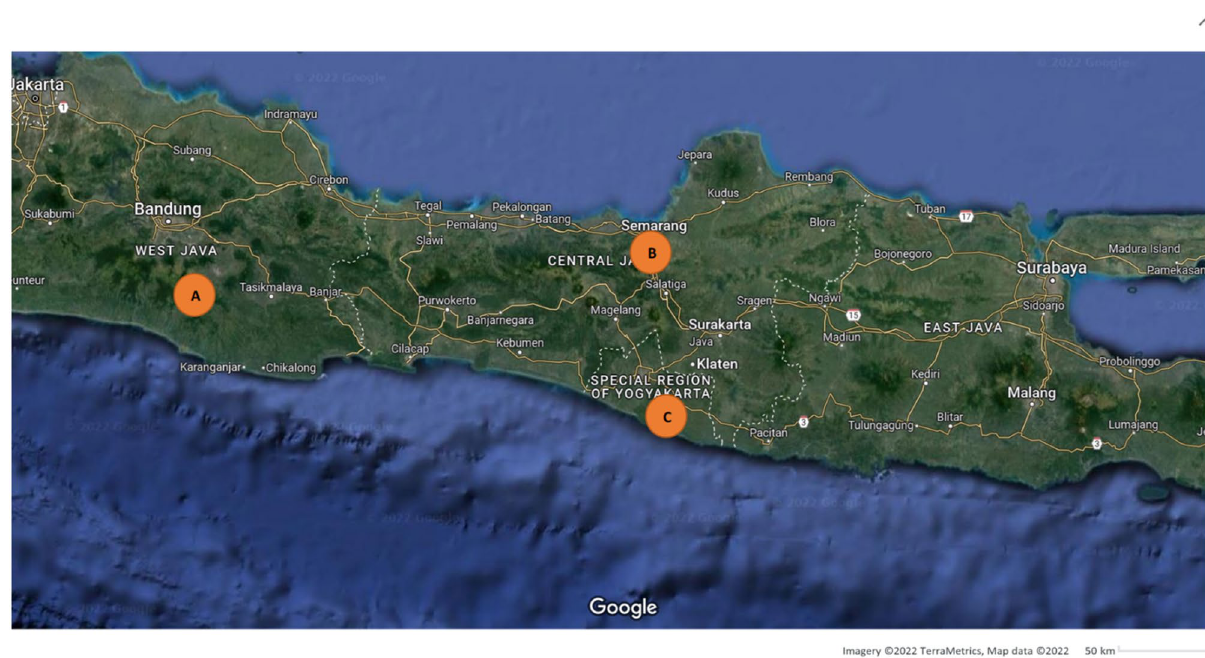
Figure 1. Java Island map with the location of the stations. ( a ). CISI, ( b ). SMRI, ( c ). UGM [Imagery © 2021 TerraMetrics, Map data © 2022